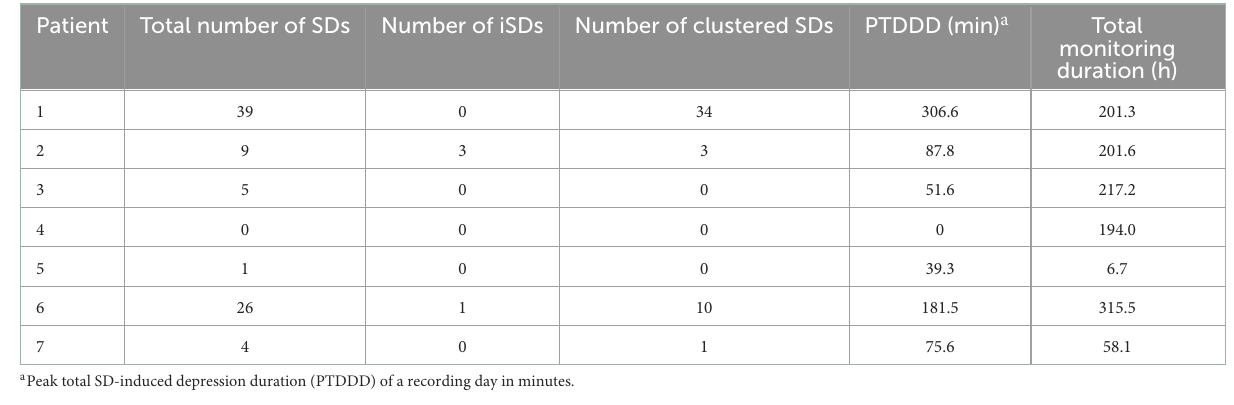
TABLE 2 SD characteristics.